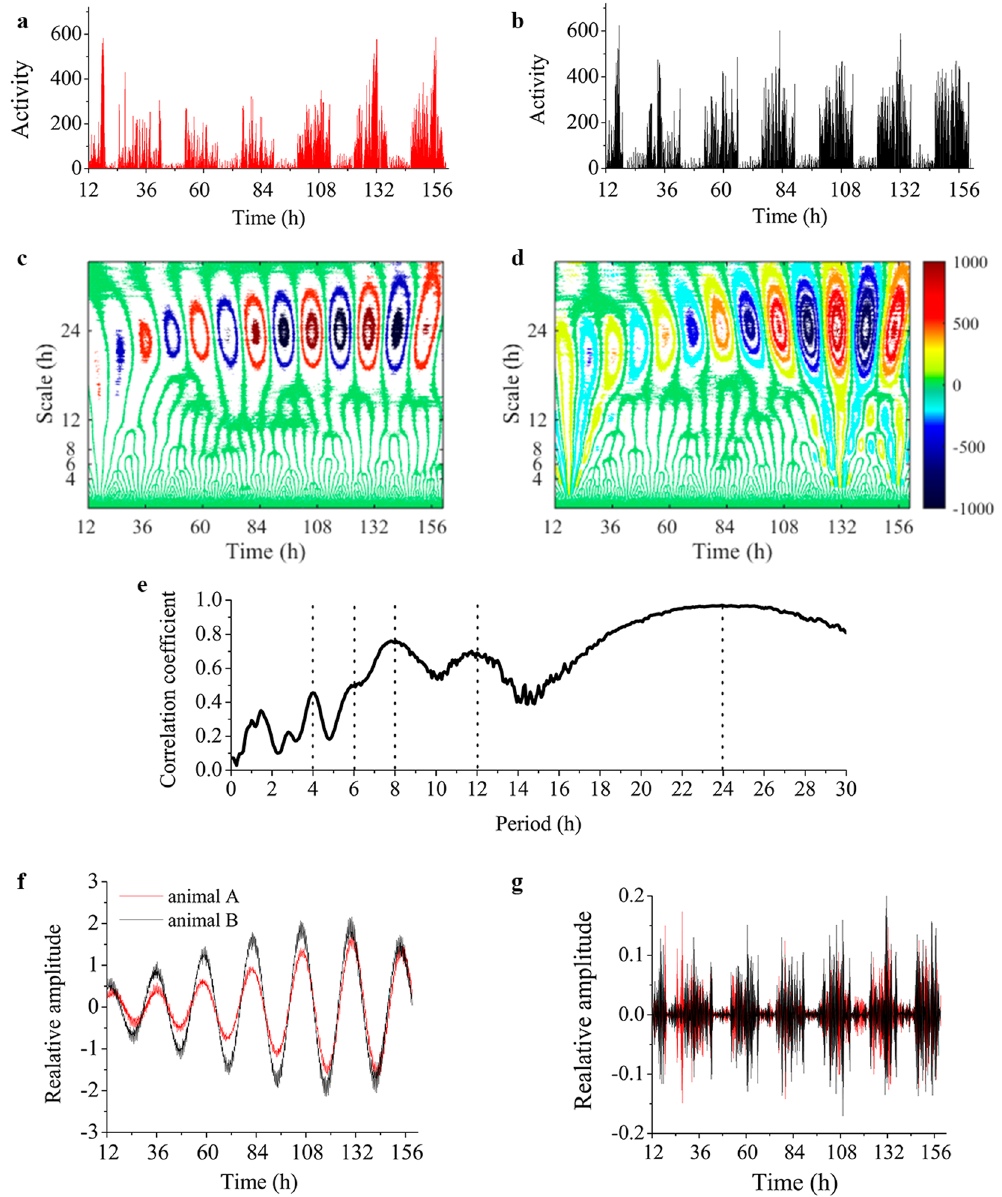
Figure 6. Synchronicity of ultradian rhythms. ( a,b ) Comparative actograms of locomotion time series (6 min bins) from two female Japanese quails. ( c,d ) Contour plot of the real part of the wavelet coefficients estimated with a complete Morlet wavelet for time series “a” and “b”. The x -axis represents time (6.5 days) and the y -axis indicates the scale of the wavelet used (from 6 min to 26 h). Yellow and red indicates higher values while blue indicates minimal amplitude values. ( e ) Representation of the diagonal correlation coefficients obtained from comparing the real component of the wavelet coefficients for the same two animals at each time scale using the Spearman correlation coefficient. Note that these correlation coefficients denote the time interval where there is effective correlation and the temporal scales at which the maximum value of the coefficients occurs. Depicted is an example of the amplitude of the wavelet coefficients at 24 h ( f ) (maximal correlation), and 0.3 h ( g ) (minimal correlation) for time series “a” and “b”. Average correlation coefficients at each time scale estimated from all pair-wise comparison between all 12 animals from the same experiment is represented in Supplementary Fig.